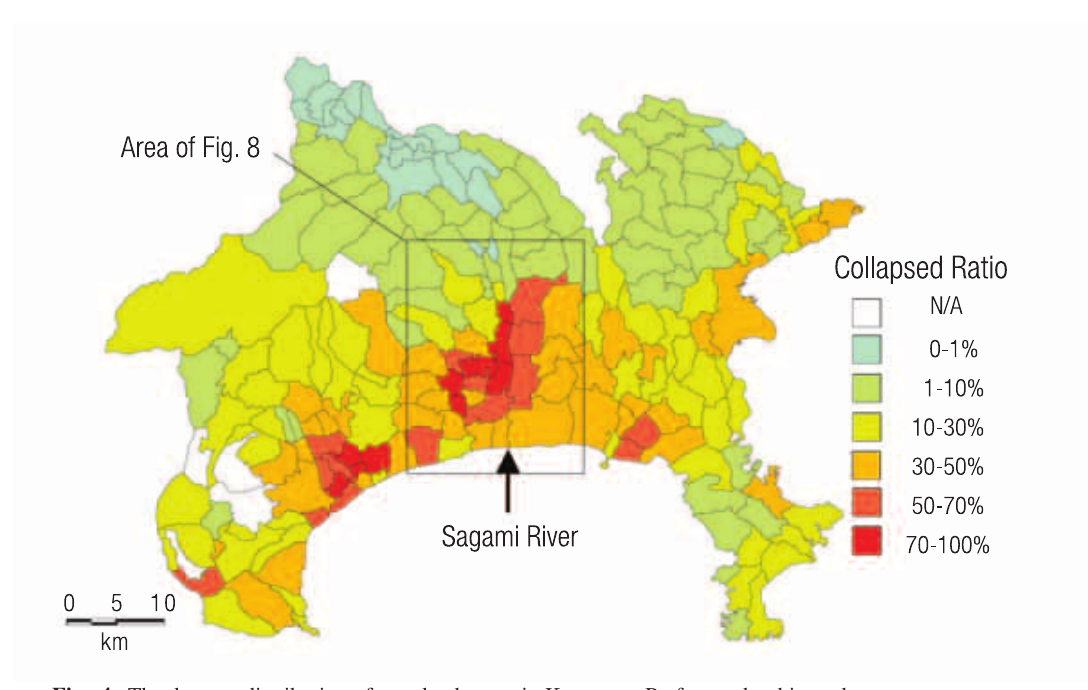
Fig. 4. The damage distribution of wooden houses in Kanagawa Prefecture by this study.